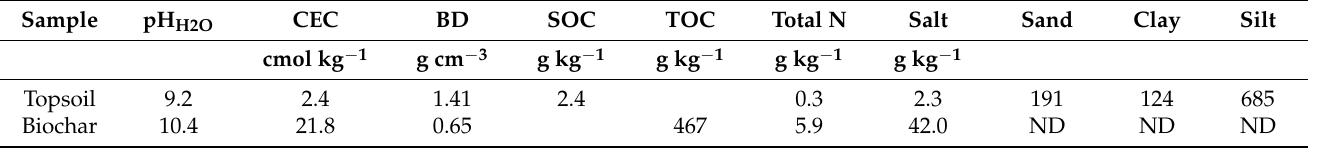
Table 1. Basic properties of the original topsoil (0–20 cm) and biochar used for the experiment.